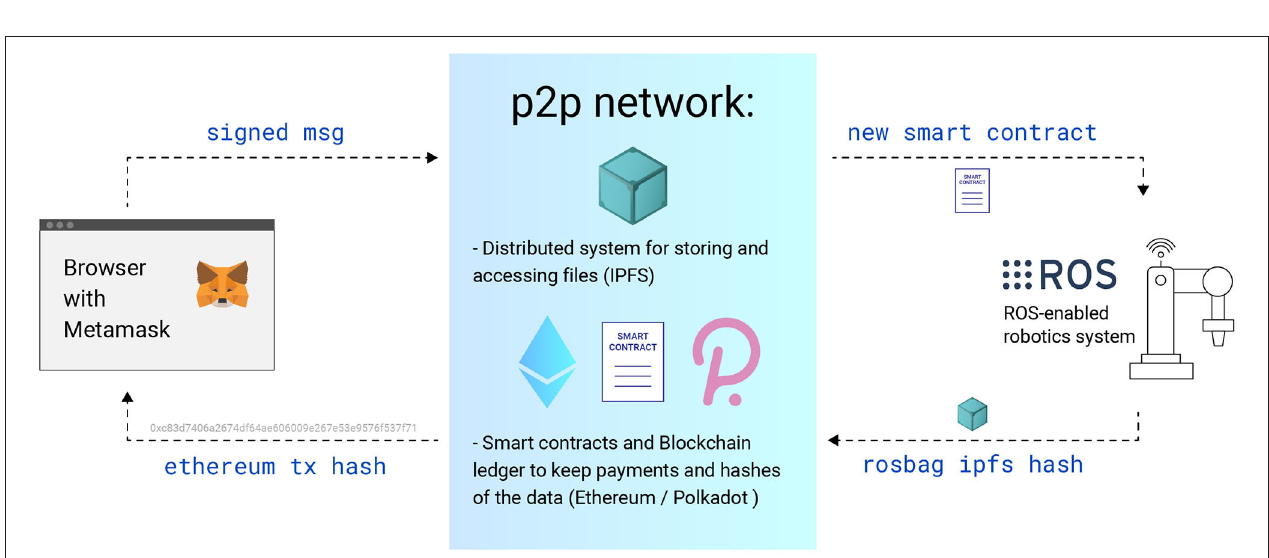
FIGURE 3 | The scheme of work of our RaaS architecture. As a Dapp for ordering a service from a robot, a regular web browser with an Metamask extension for access to cryptocurrency wallets is used.